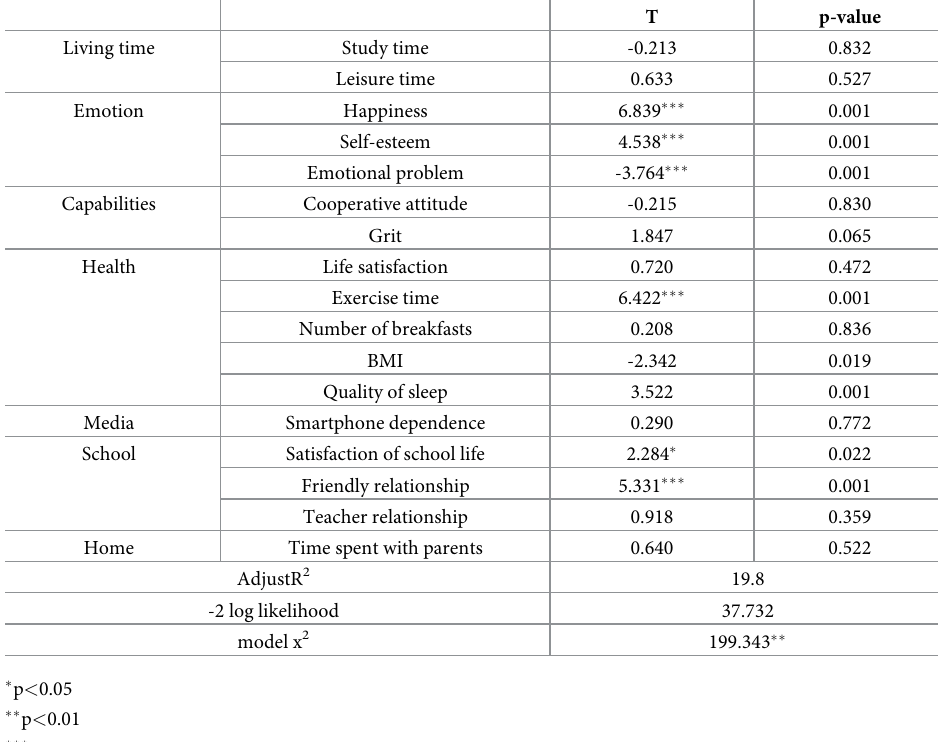
Table 4. Factors affecting subjective health conditions of first-year middle school